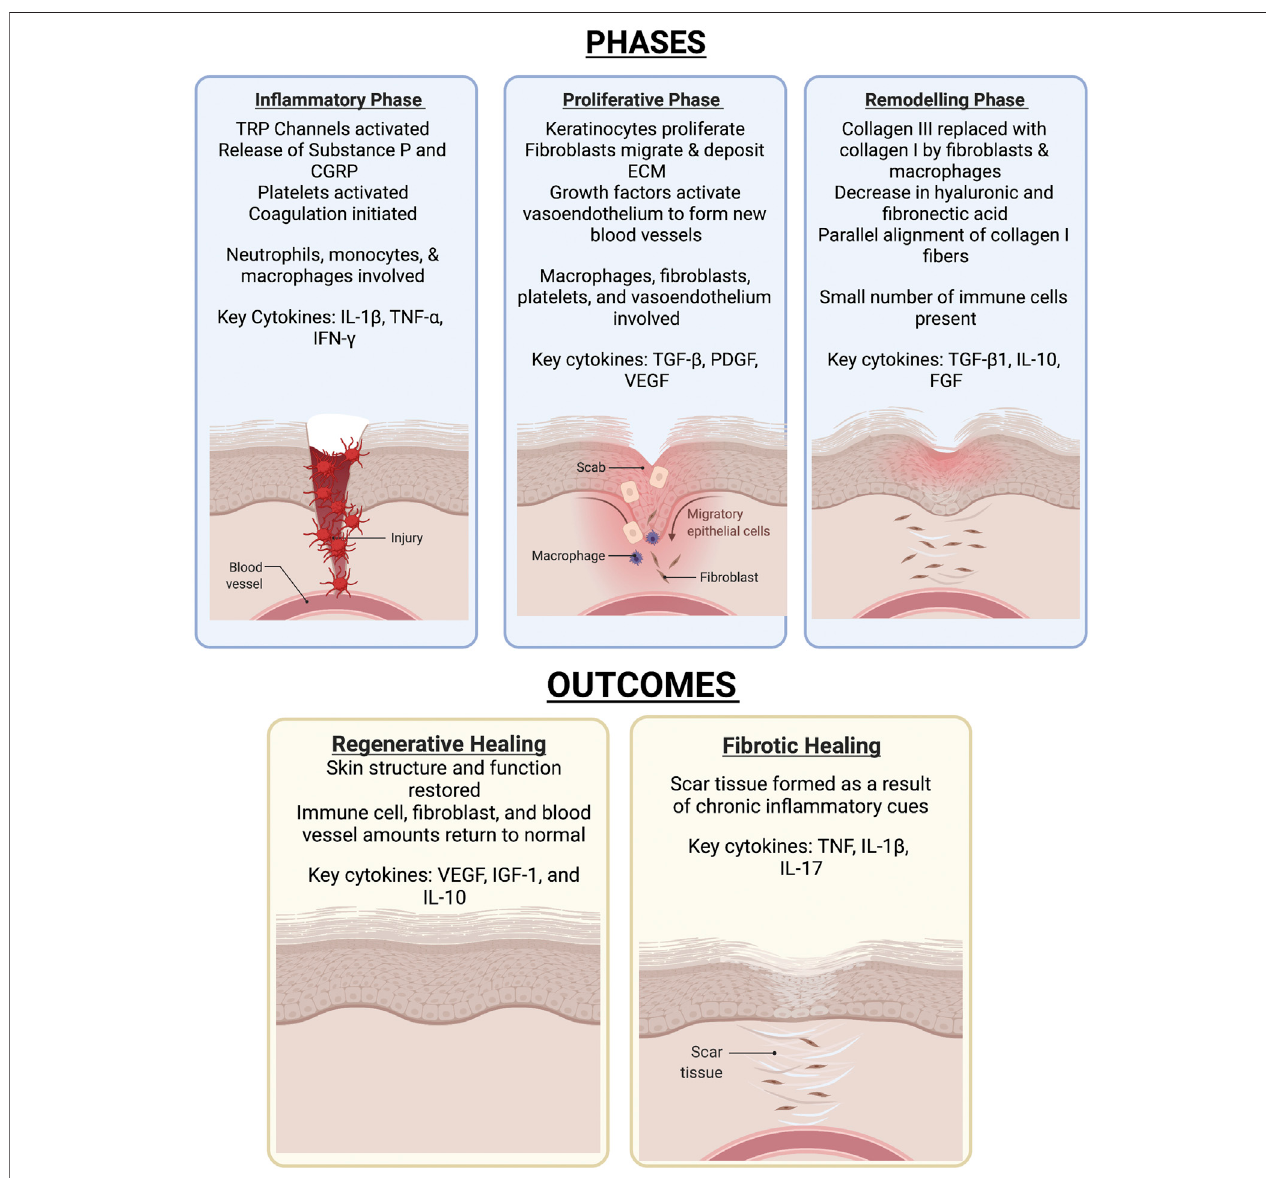
FIGURE 3 | The various phases of skin wound healing and the outcomes. Skin healing consists of three phases-the in fl ammatory, proliferative, then remodelling phase. The outcome of the healing process results in either full resolution of injury or formation of a scar.